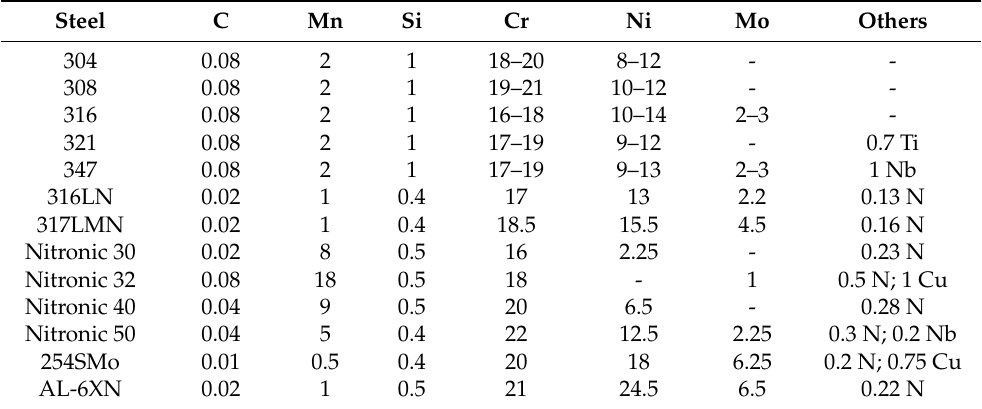
Table 7. Chemical composition of austenitic and superaustenitic steels, wt%. Data from [32]. Steel